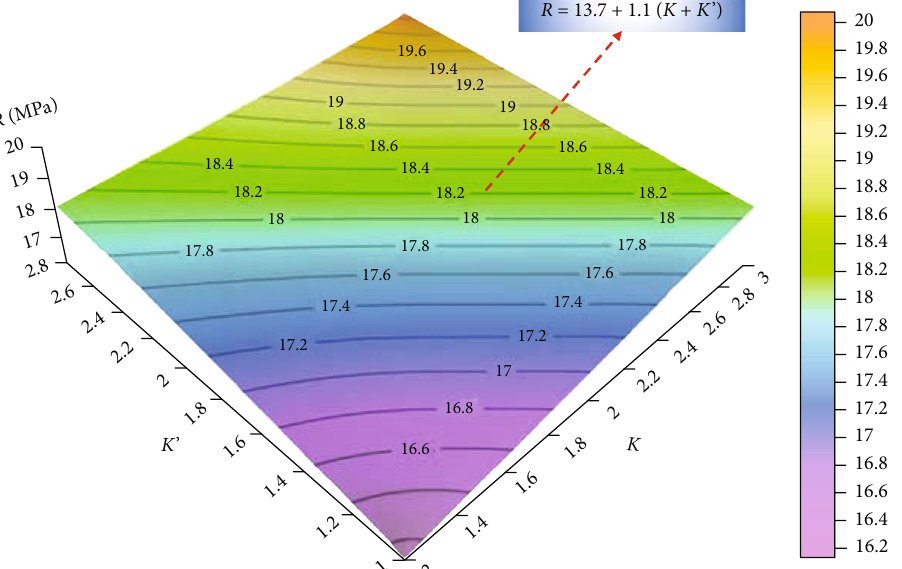
Figure 6: Variation curve of R with K and K ′ .